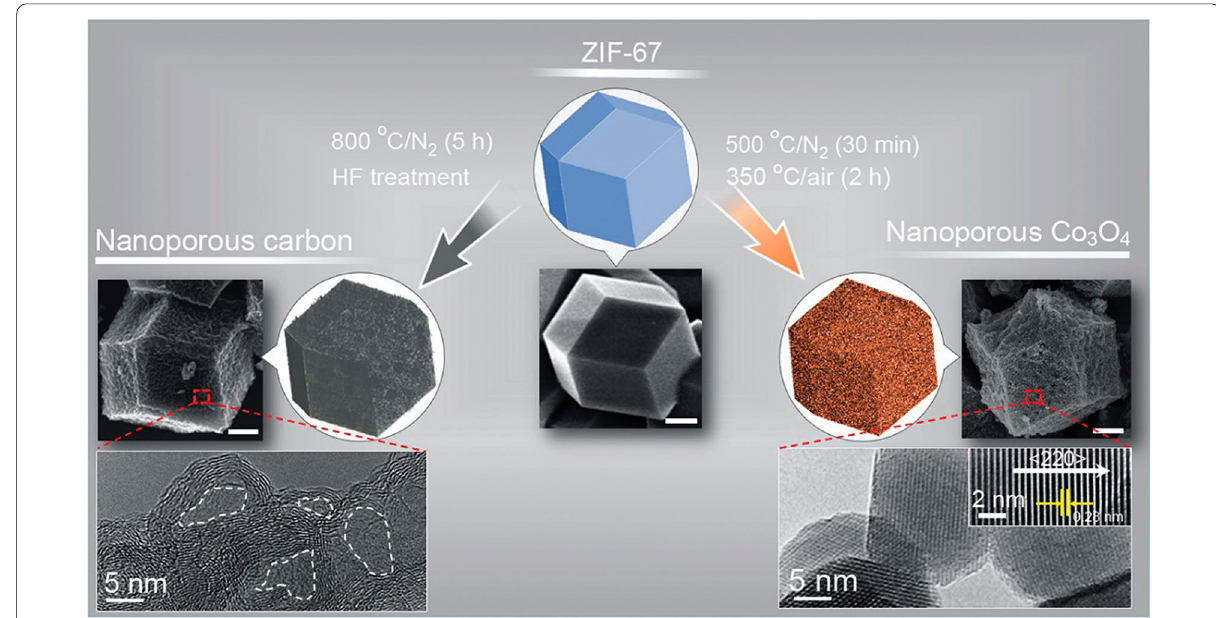
Fig. 3 Schematic representation of the preparation of nanoporous carbon and nanoporous Co 3 O 4 from a ZIF-67 polyhedron with their respective SEM and high-resolution TEM images. The scale bar for SEM image is 500 nm in length. TEM analysis suggests the removal of cobalt nanoparticles from the nanoporous carbon surface after thermal treatment and HF washing (as marked by the white dotted lines). However in the case of Co 3 O 4 , the optimized heating conditions result in the conversion of the ZIF-67 polyhedron into an oxide polyhedron. Reproduced with permission